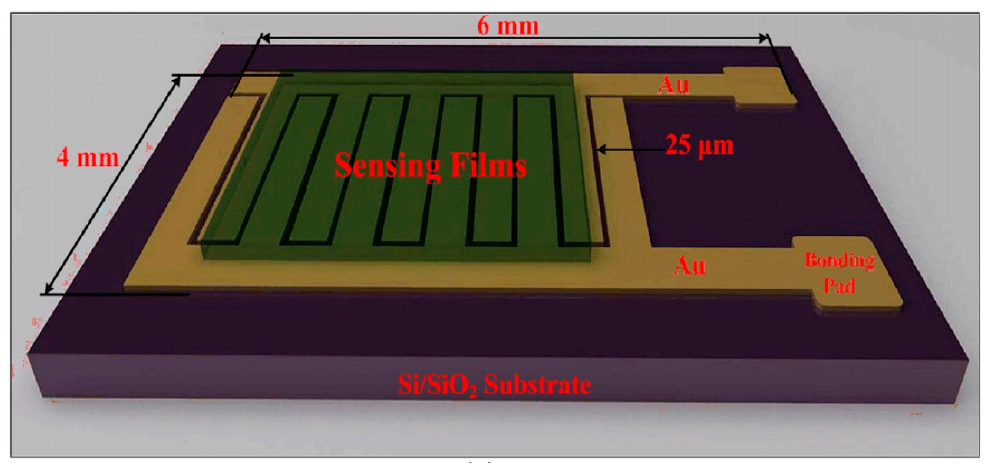
Figure 2. Schematic illustration of a chemiresistor (adapted from ref. [42], Copyright 2013, with permission from Elsevier, Amsterdam, The Netherlands).